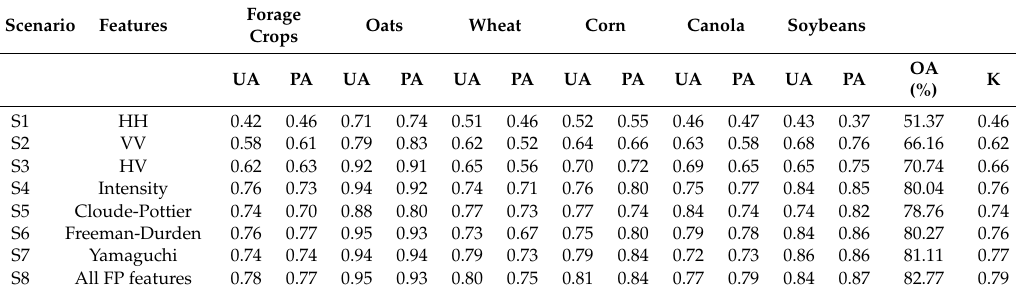
Table 5. Classification results obtained from extracted features from multi-temporal FP SAR data (see Table 3 for an exact description of extracted features in di ff erent scenario in this study). Scenario